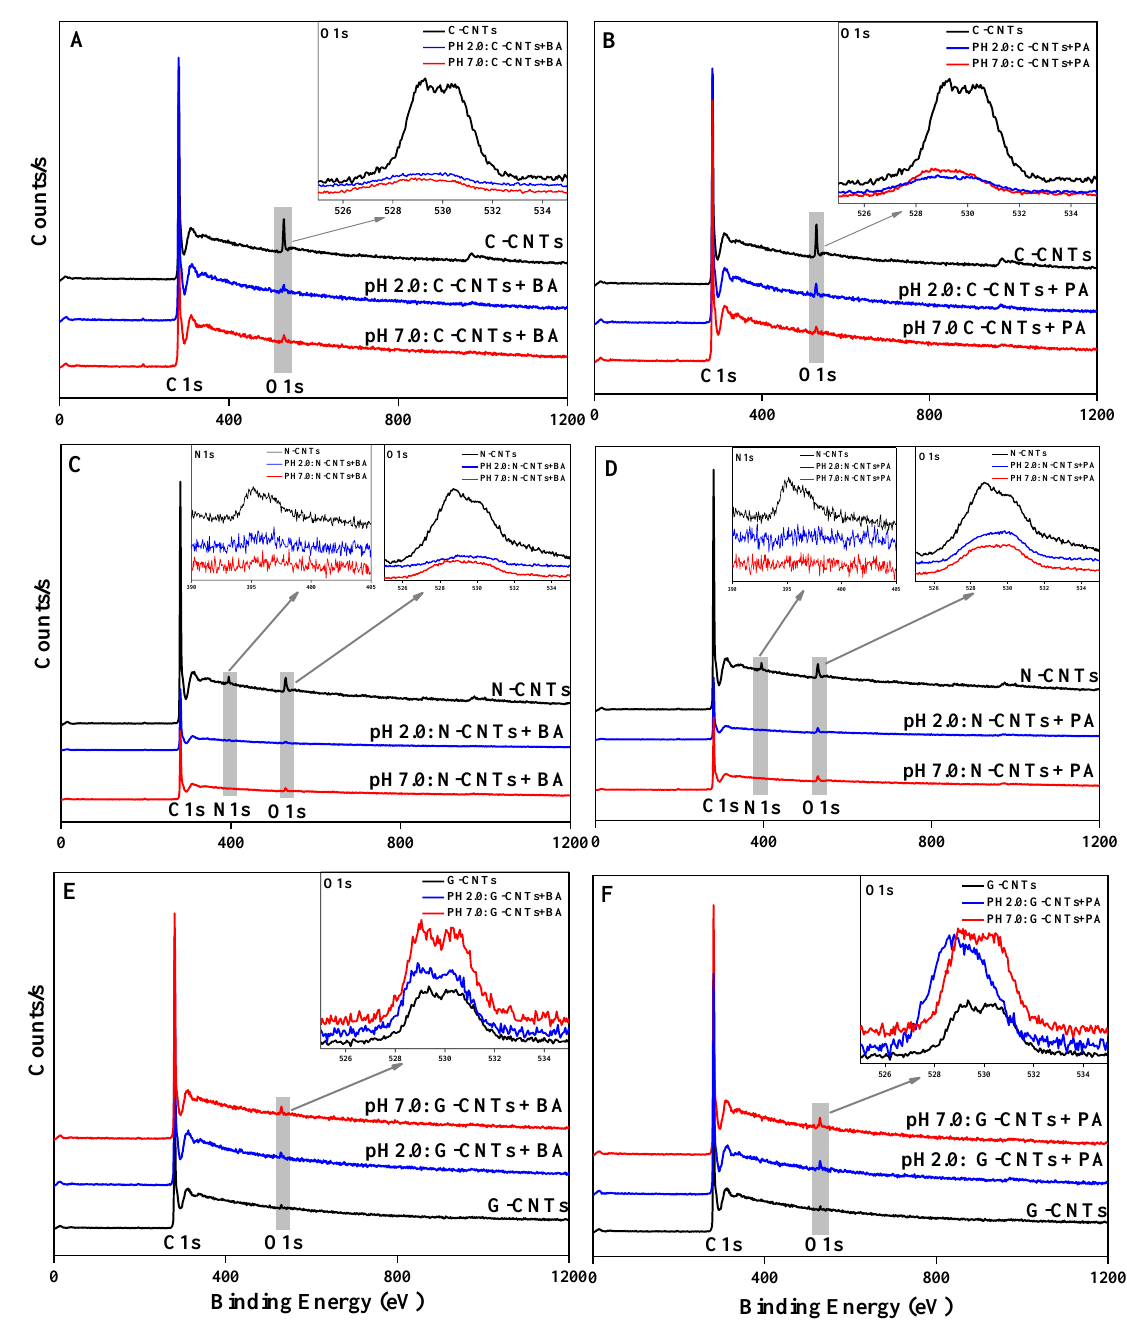
Figure 4. The XPS spectra of O-CNTs ( A, B ), N-CNTs ( C, D ), and G-CNTs ( E, F ) with loaded and unloaded IOCs. For N-CNTs (Figure 5B), after adsorption of BA or PA, the characteristic peaks NH 2 (3433, 3160, 810~616 cm − 1 ) and N-H (1570 cm − 1 ) of N-CNTs all disappeared at pH 2.0, indicating that BA and PA also could interact with these functional groups of N-CNTs by ordinary H-bonds. What is noteworthy is that, at pH 7.0, there was no new peak arose in